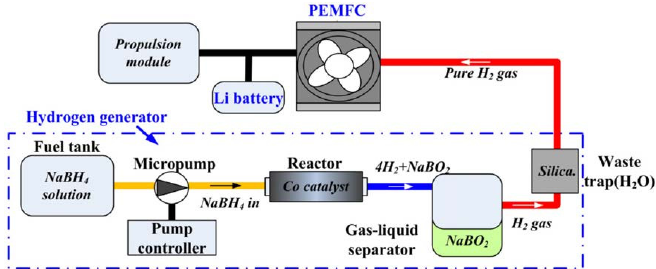
Figure 5. Operating principle of fuel cell system equipped in the unmanned aerial vehicle (UAV) platform. Reprinted with permission from reference [98]. Copyright 2011 Elsevier.